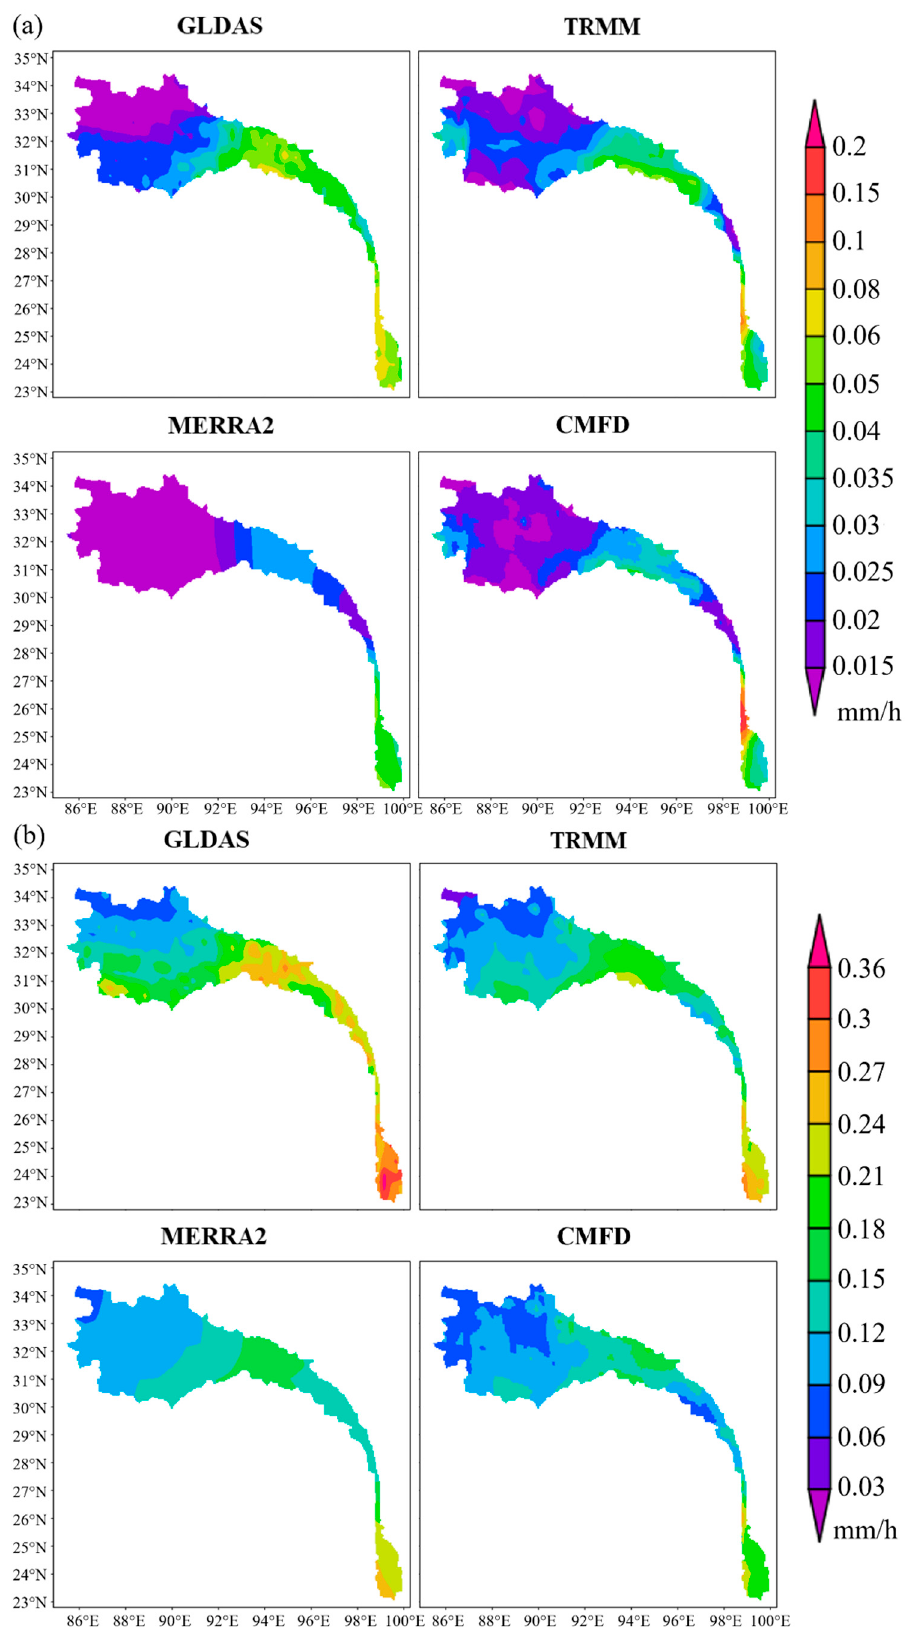
Figure 4. Mean (2012–2016) spatial distribution of precipitation during the non-monsoon season ( a ) and monsoon season ( b ) from four precipitation products .